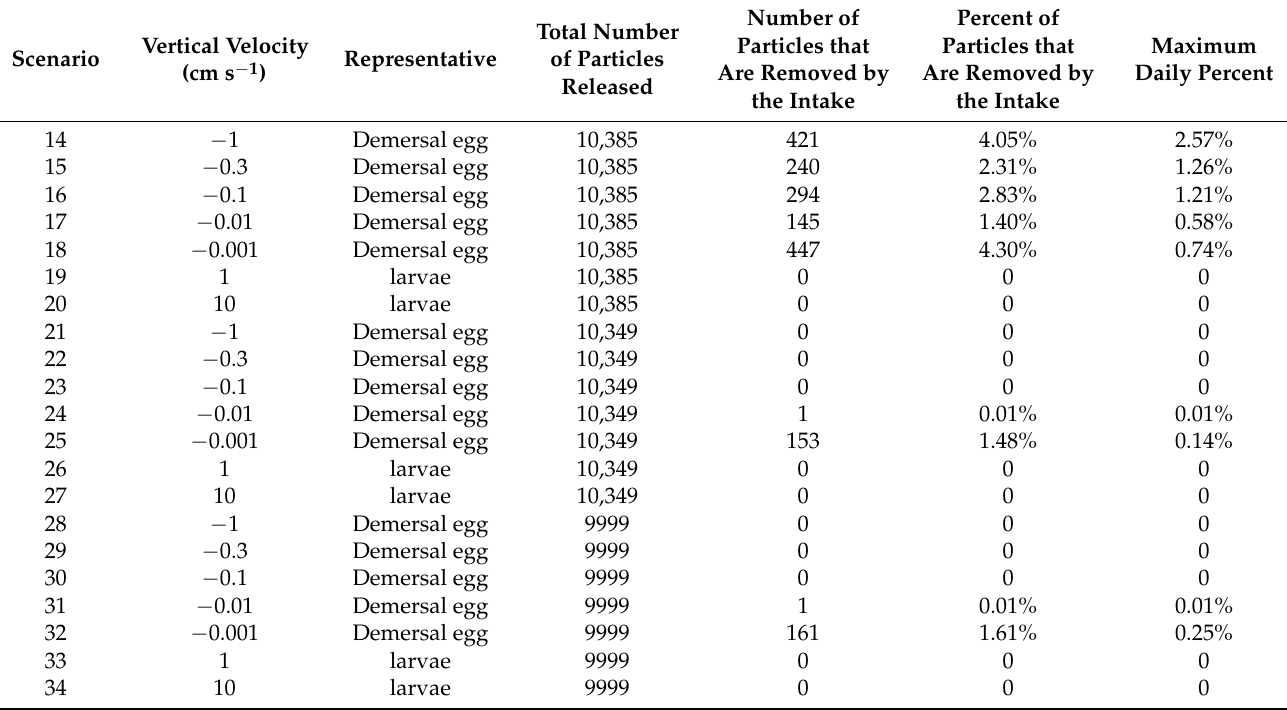
Table 5. The statistics of forward particle tracking scenarios 14–34. The vertical velocity of the particle can be either upward (+) or downward ( −